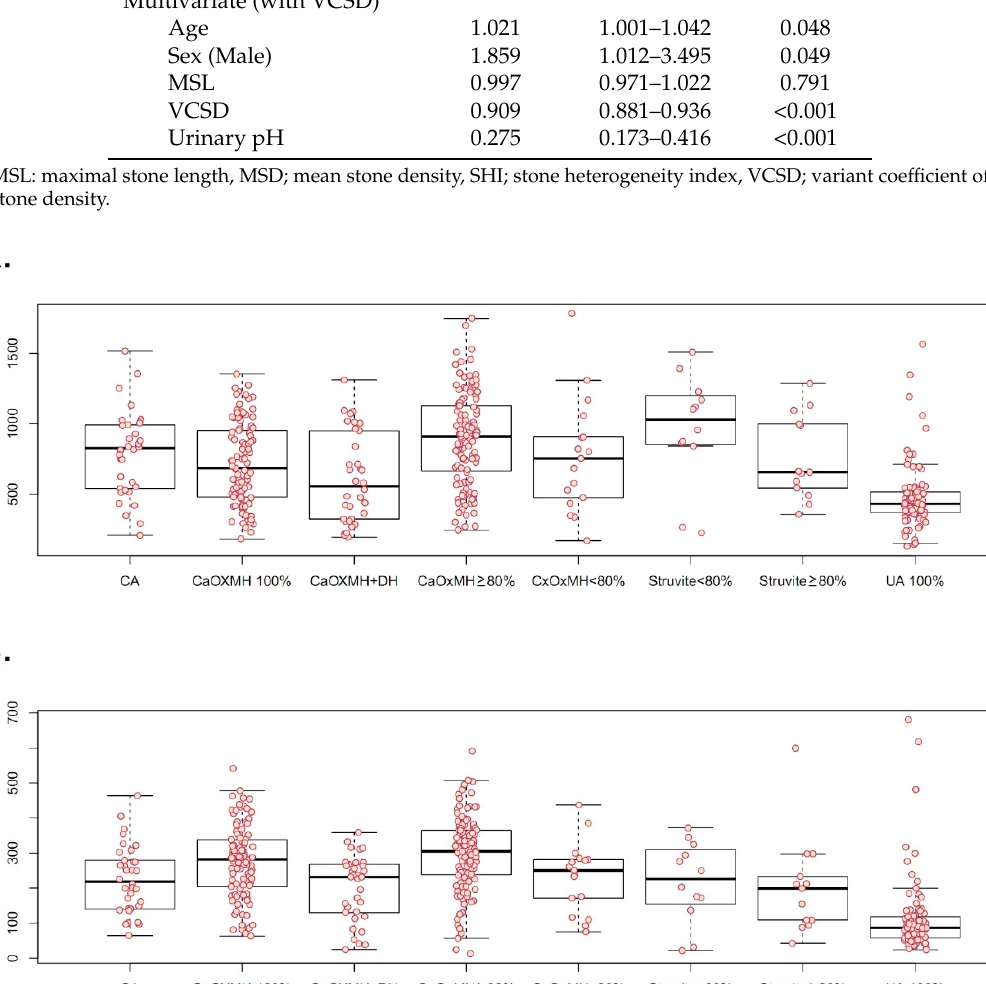
Figure 2. Variant coefficient of stone density (VCSD; determined via non-contrast computed tomography) ( A ) and urinary pH ( B ), shown by stone composition. CA: carbonate apatite; CaOx: calcium oxalate; MH: monohydrate; DH: dihydrate; UA: uric acid.